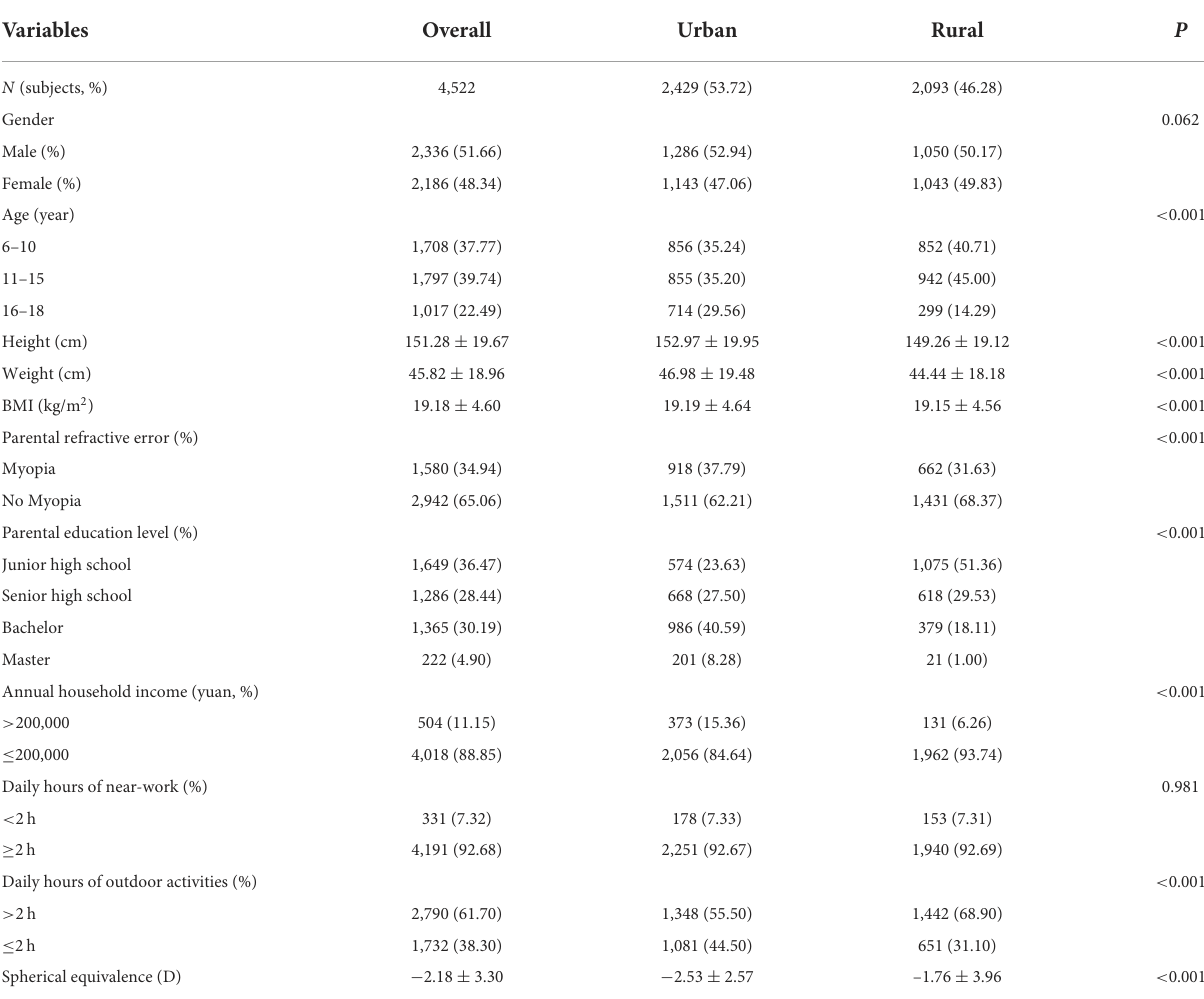
TABLE 1 Characteristics of all